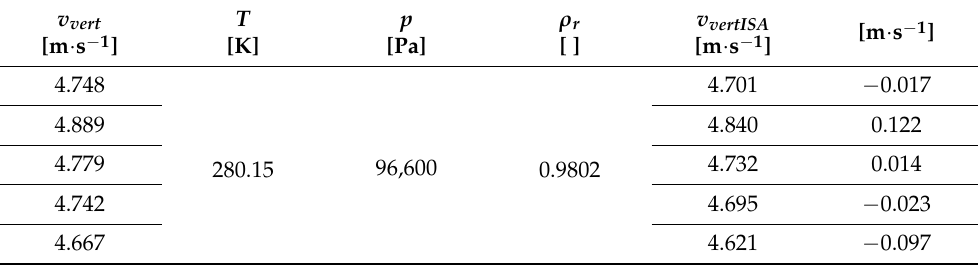
Table A1. Results of the test jump number